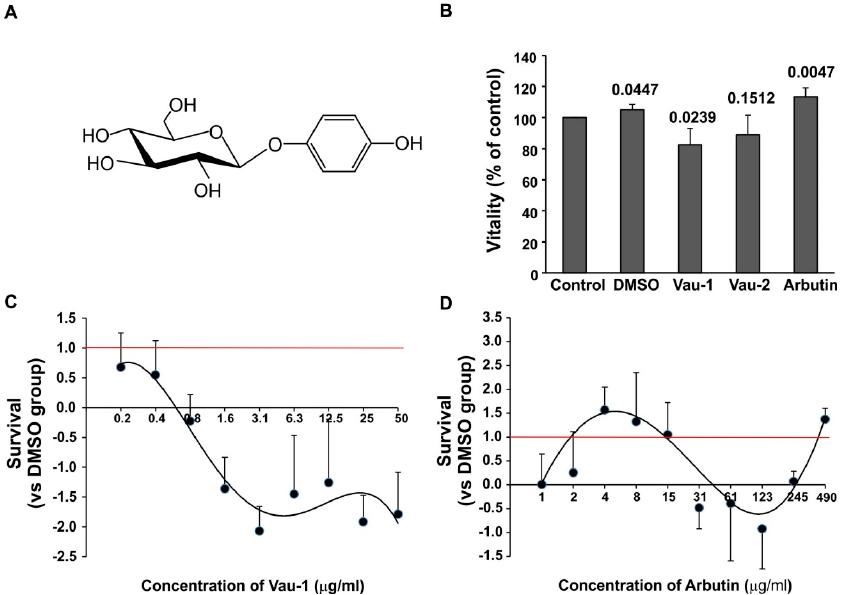
Figure 2. Effect of the Vau-1/Vau-2 extracts or arbutin on neutrophil vitality and survival. ( A ) Chemical structure of arbutin; ( B ) Vitality of bone marrow (BM)-derived neutrophils compared to control cultures. Vitality was calculated as a percentage of control cultures containing cells only. Data represent mean ± SD of cell samples isolated from 7 mice and plated in triplicate. P values are shown for each group when compared to control; ( C ) Dose-dependent effect of Vau-1 on DMSO-induced survival of BM-derived neutrophils. Data represent mean ± SD of sample isolated and pooled from 7 mice and run in triplicate. Red line shows the survival (relative value) at DMSO-treated group. Black line is the polygonal trend line drawn to extrapolate the vitality vs. Vau-1 extract concentration; ( D ) Dose-dependent effect of arbutin on DMSO-induced survival of BM-derived neutrophils. Data represent mean ± SD of samples isolated from 7 mice and plated in triplicate. Red line shows the survival (relative value) at DMSO-treated group. Black line is the polygonal trend line drawn to extrapolate the vitality vs. the arbutin concentrations.